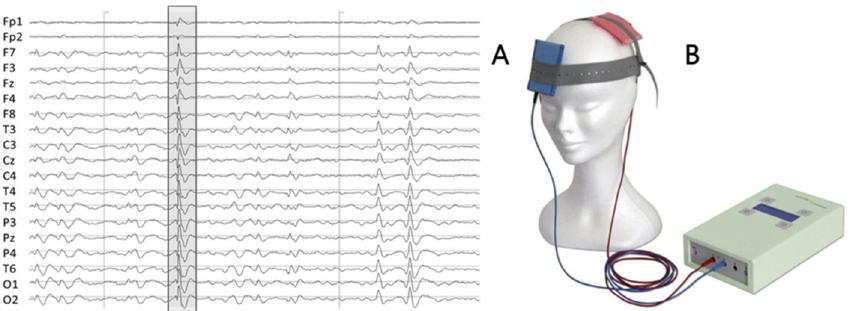
Figure 2. ( A ) An example of 2 s patient’s EEG, with typical interictal epileptiform discharge (IED) for this patient (irregular spike ‐ and ‐ wave complex) highlighted. ( B ) Battery ‐ driven stimulator and two saline ‐ soaked sponge